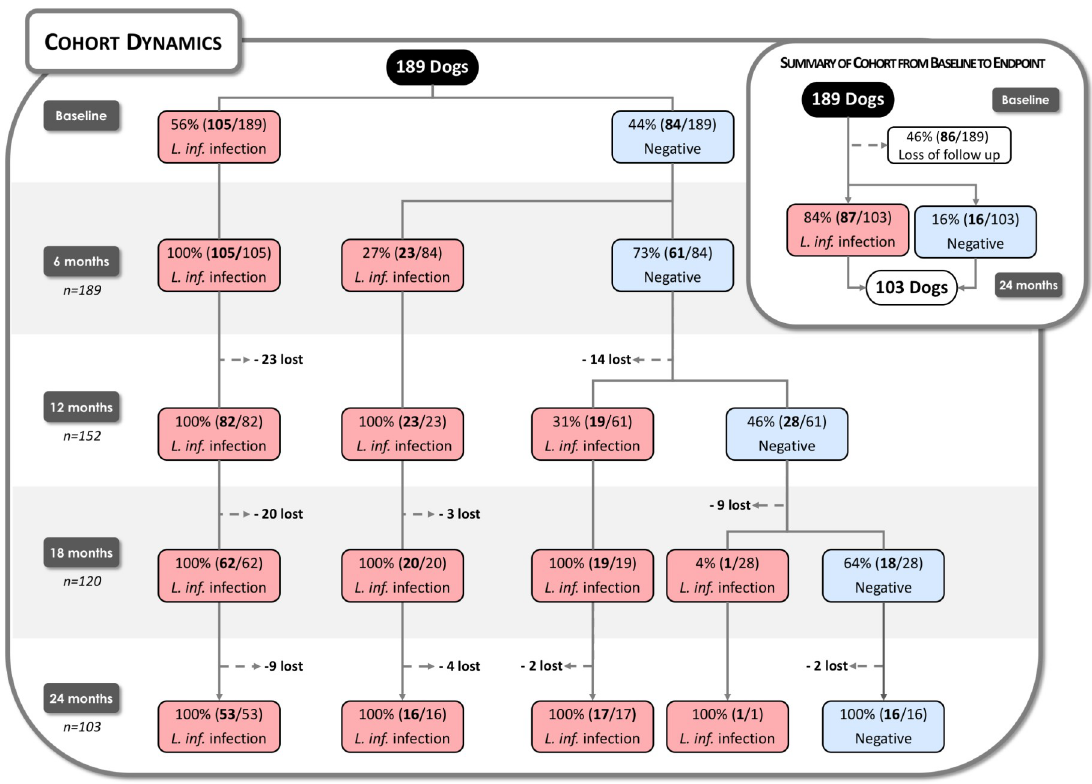
Fig 1. Cohort Dynamics. A total of 189 dogs were followed for 24 months, with Leishmania infantum infection assessed at six-month intervals. Red rectangles represent dogs presenting L . infantum infection at each follow-up point, while blue rectangles depict uninfected evaluated animals. Dotted lines represent a loss to follow-up. Summary of the cohort from baseline to endpoint reveals a 46% loss during the study, i.e., 54% remained throughout the two-year follow-up